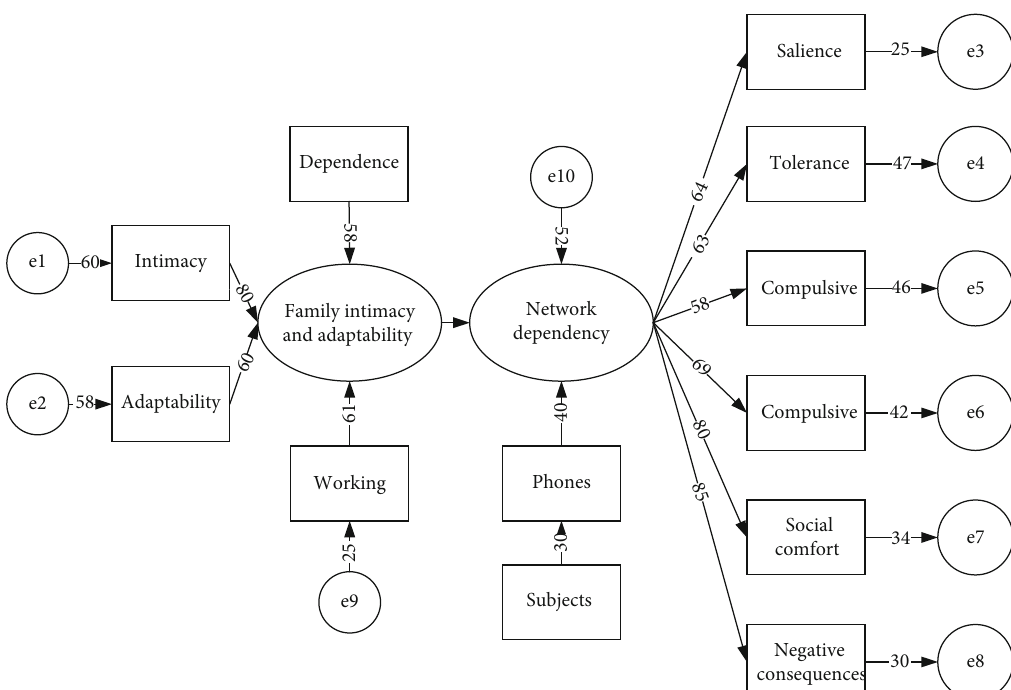
Figure 1: Model of the total e ff ect of family closeness and adaptability on network